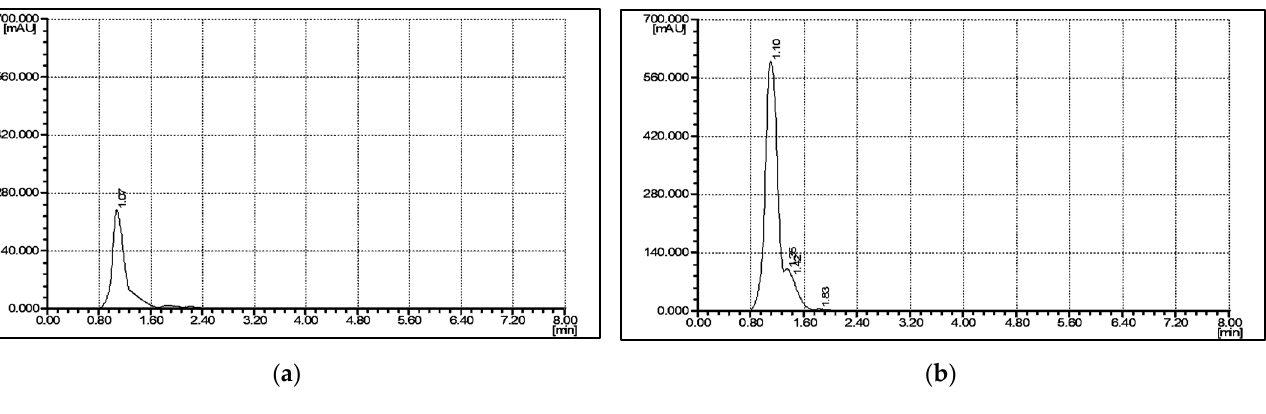
Figure 1. ( a ) HPLC chromatogram of HMF standard; ( b ) HPLC chromatogram of HMF content of the biscuit sample (BSC2-U) which showed the highest level of HMF.